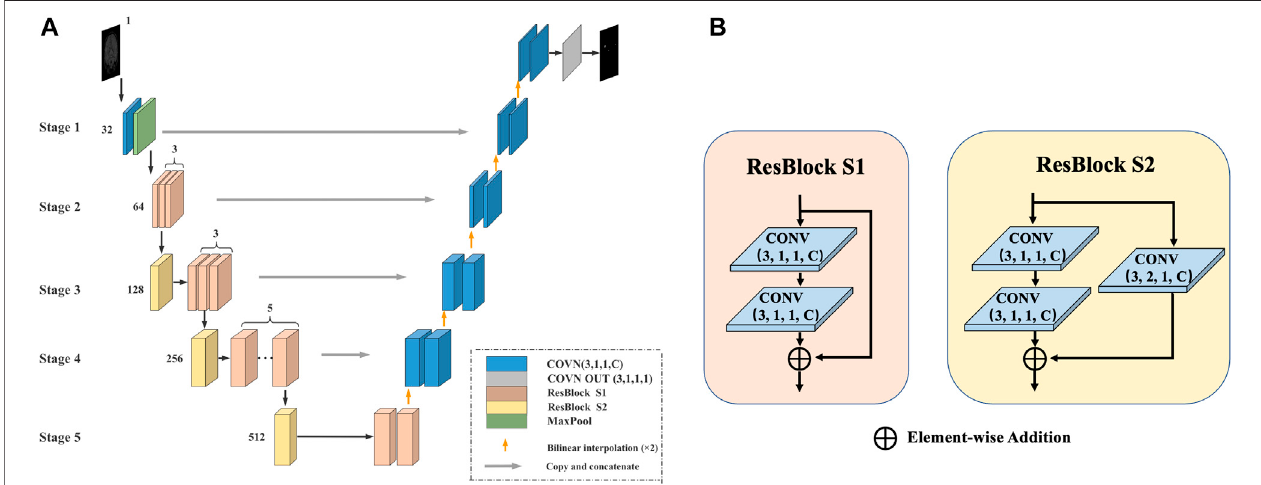
FIGURE2| The fi rststageofthe method. (A) U-Net model for coarse segmentation:The number representsthe number ofchannels, theencoder is replaced with Res-Blockduringtheencodingprocess,andthedeconvolutionisreplacedwithbilinearinterpolationduringthedecodingprocess. (B) Res-BlockS1/S2:TheRes-Block S1 module contains two convolutional layers and uses shortcut connections to ensure the consistency of the gradient. The Res-Block S2 module adds a convolutional layer to the base of S1.